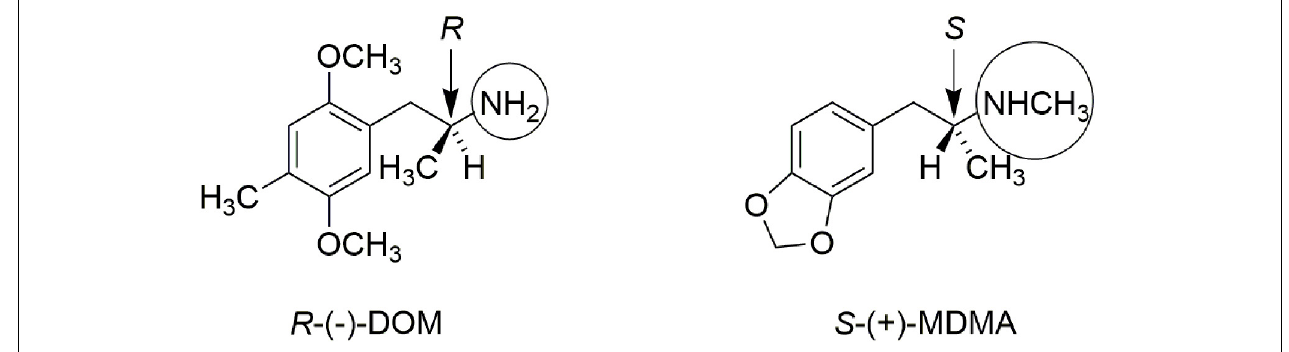
FIGURE 1 | Comparison of the more active enantiomers of DOM and MDMA. Note the opposite stereochemistry at the alpha-carbon atom. Note also that DOM has a simple primary amine (circled) whereas MDMA is a secondary N-methylamine (also circled).